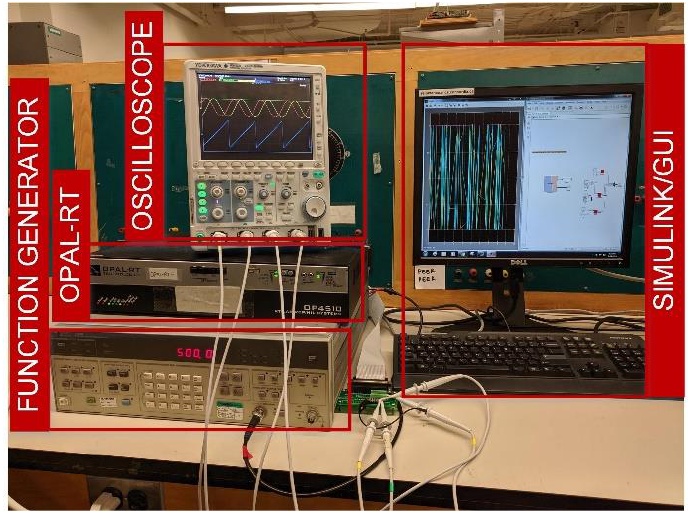
Figure 20. Experimental setup built for the system validation.